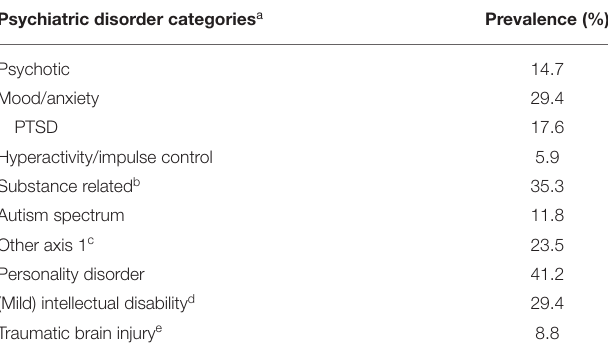
TABLE 3 | Prevalence of possible psychiatric disorders in subjects ( N = 34) included in a case-based approach of radicalization in Amsterdam (January